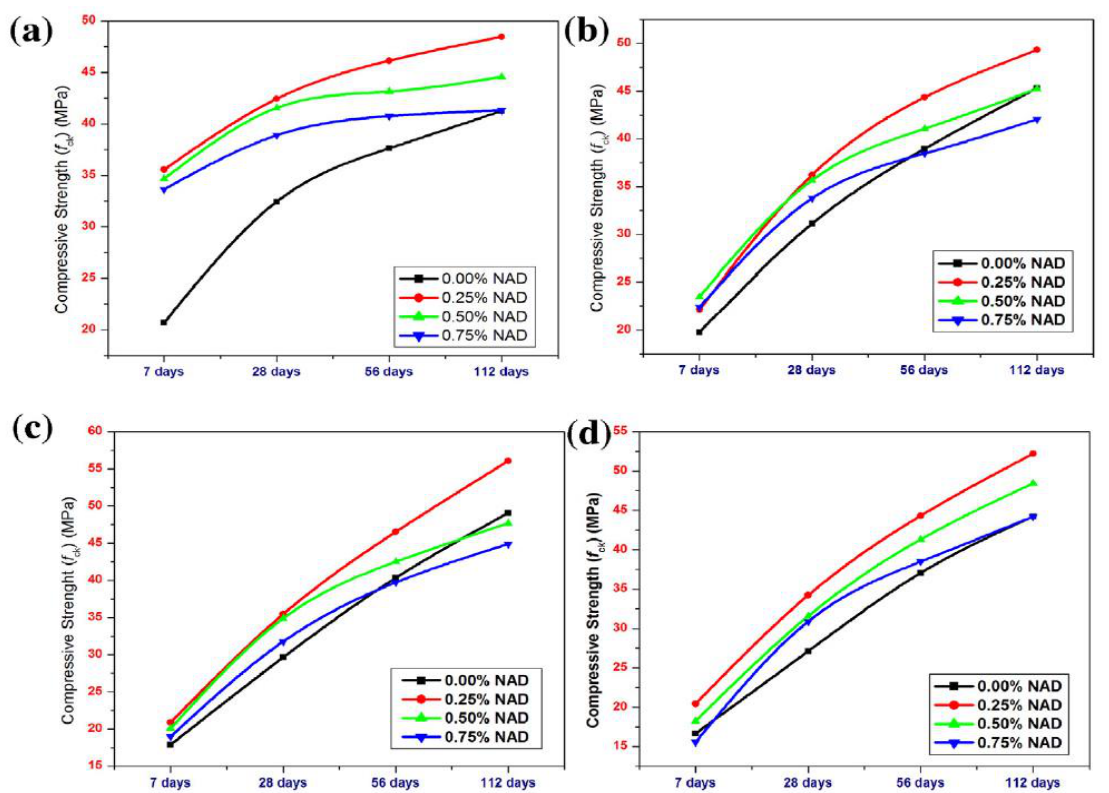
Figure 15. Test results Broiler egg with different ratios of Class F fly ash (FA) affecting concrete